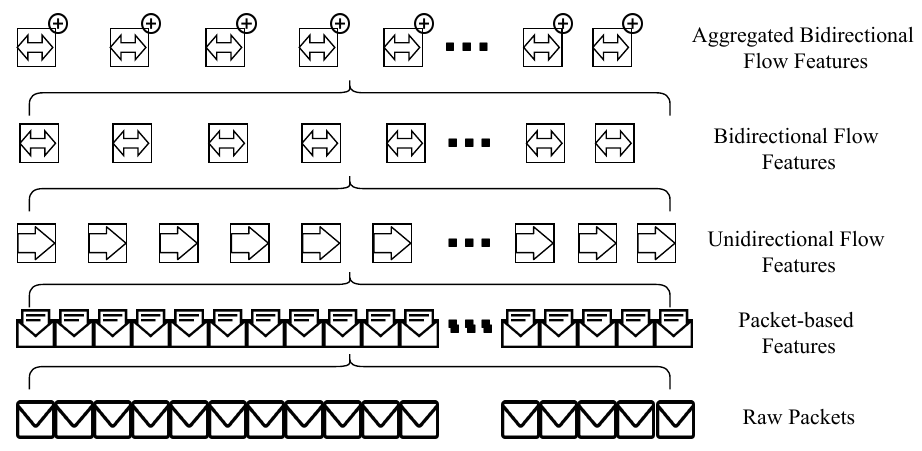
Figure 1. Networking features abstraction levels.